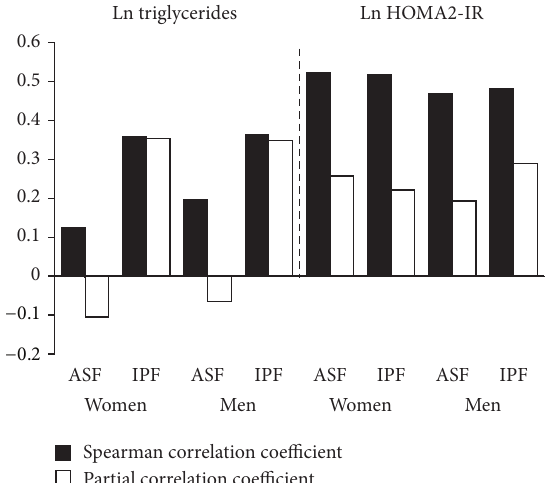
Figure 6: Black bars show Spearman correlation coefficients ( r ) for regression analyses of ln triglyceride and ln HOMA2-IR versus abdominal subcutaneous fat (ASF) and intraperitoneal fat (IPF) in women and men. White bars show partial correlation coeffi- cients after adjustment for the opposite fat compartment. For this analysis, all men and all women were combined. For triglycerides, ASF was modestly correlated but became negatively correlated after adjustment for IPF. IPF was more strongly correlated with triglycerides and remained equally correlated after adjustment for ASF. Both ASF and IPF were strongly correlated with ln HOMA2- IR, but after adjustment for the opposing compartment, partial correlation coefficient was diminished. All correlation coefficients were significant at a level of 𝑃 < 0.001